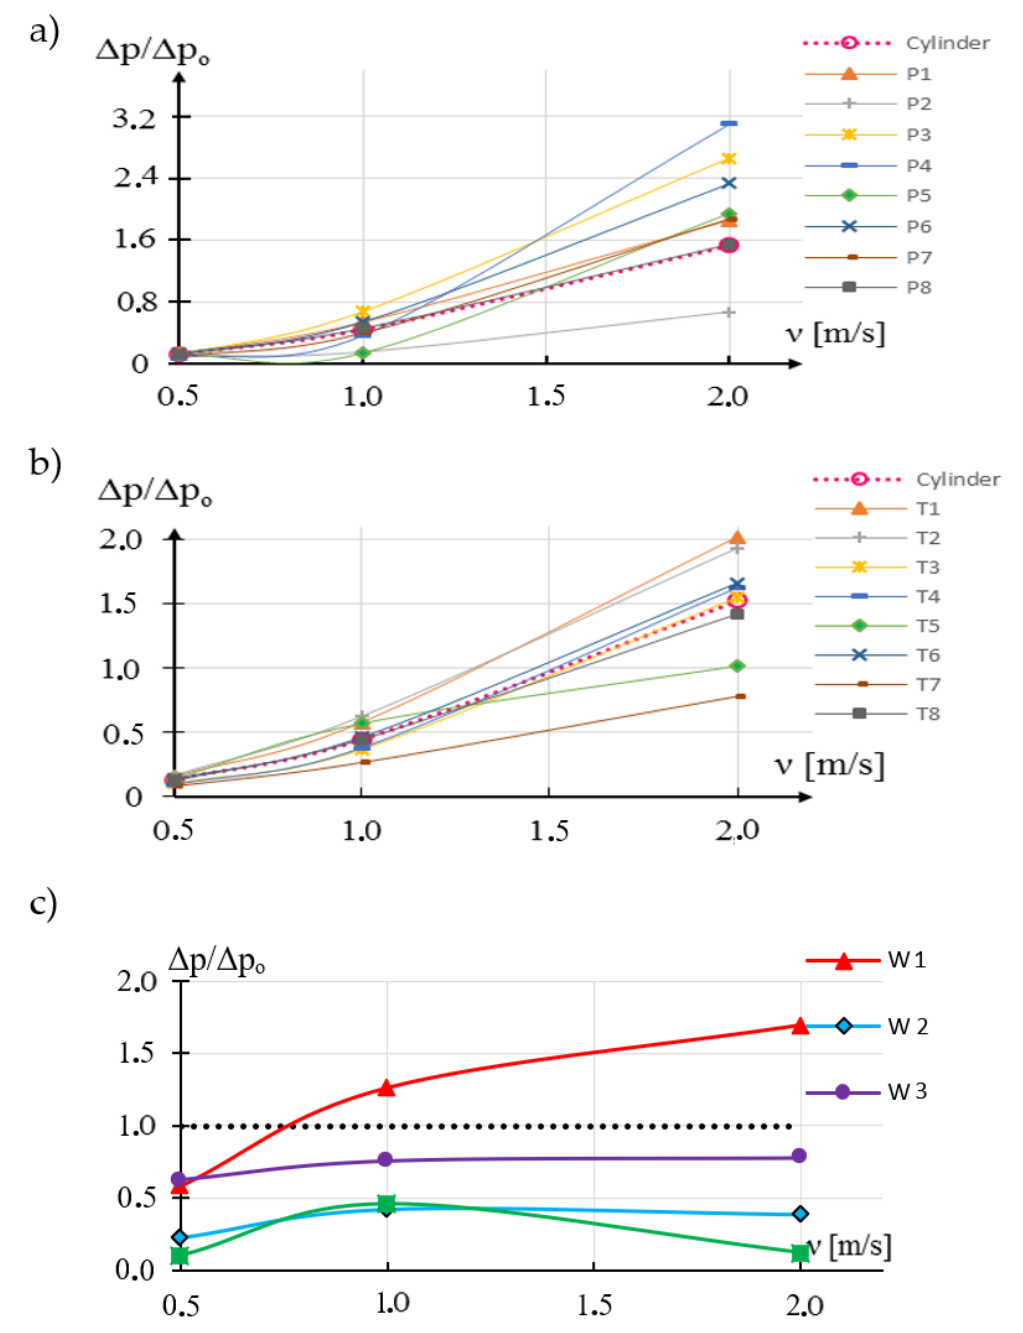
Figure 7. Shapes resulting from ( a ) rake surface modification ( b ) runoff surface modification ( c ) oval.